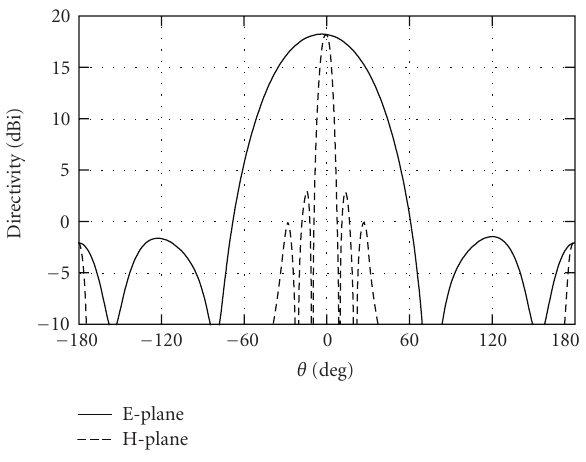
Figure 14: Radiation patterns at 1.96 GHz.